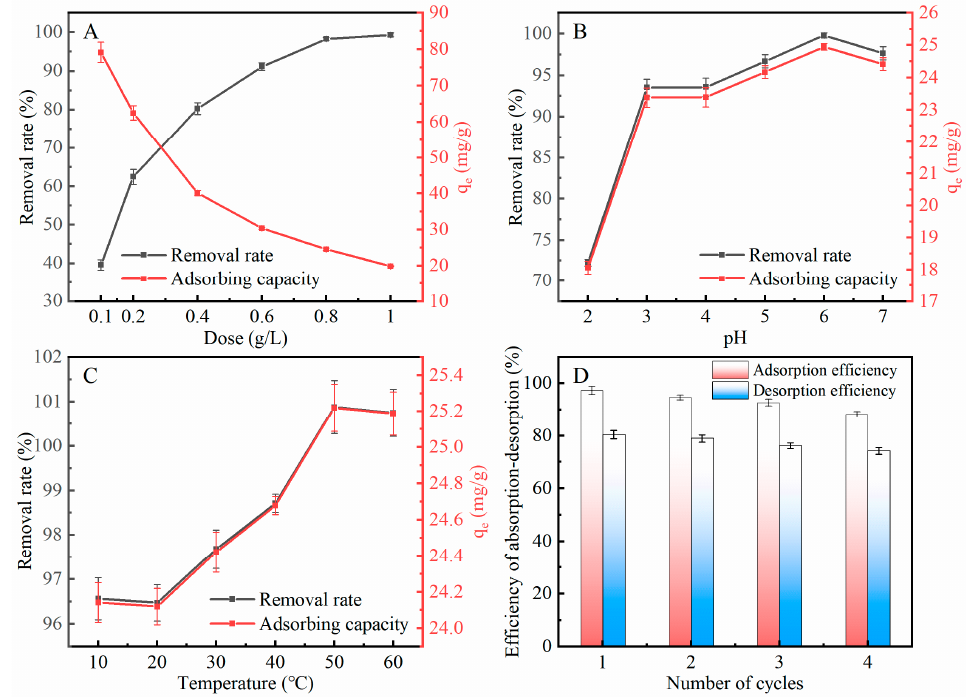
Figure 6. Effects of ( A ) dose, ( B ) wastewater pH, ( C ) temperature and ( D ) number of cycles on the removal rate and the adsorption capacity. Error bars represent the standard deviation from three repetitions.